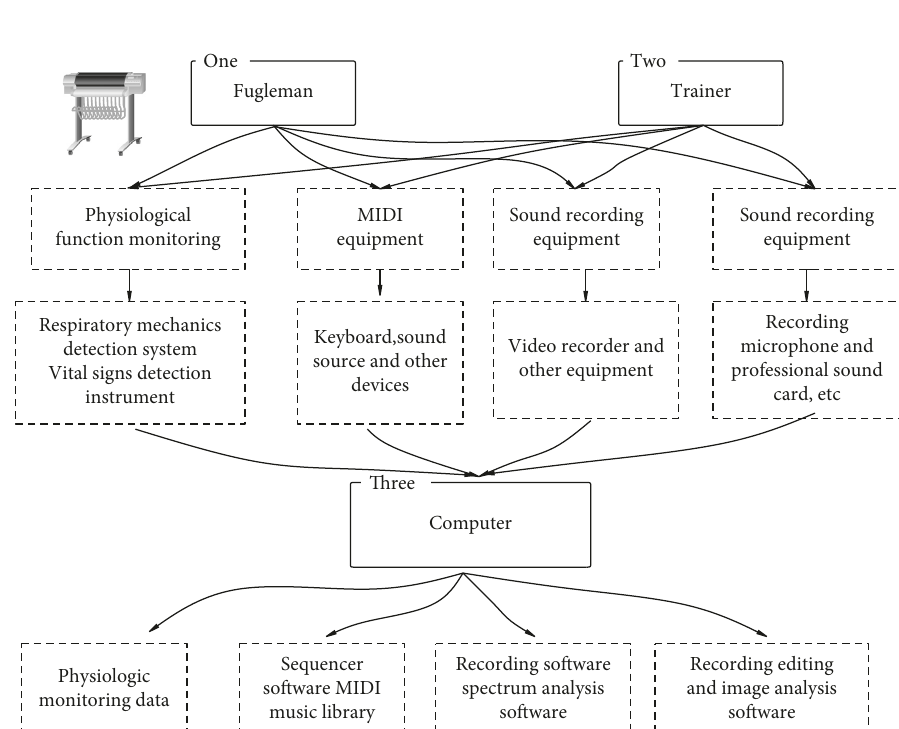
Figure 13: External facilities and equipment